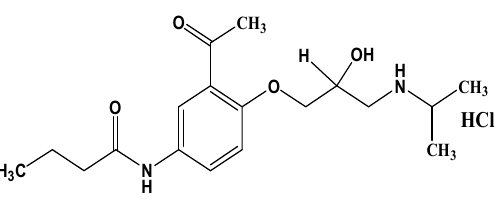
Figure 1. Chemical structure of acebutolol